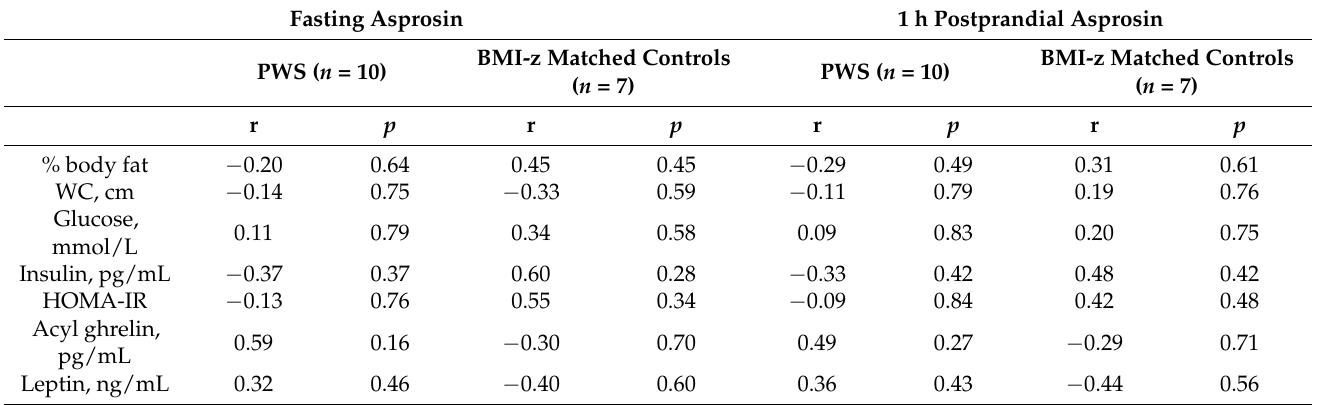
Table 4. Partial correlation of fasting asprosin to other metabolic parameters adjusting for age and sex in children with Prader–Willi syndrome and BMI-z matched